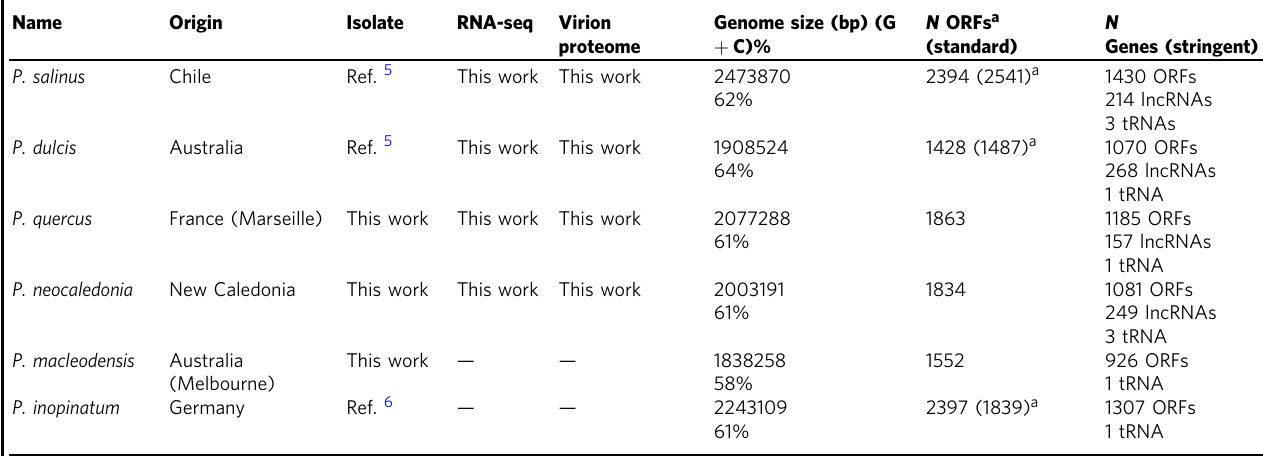
Table 1 Data on the pandoravirus isolates used in this